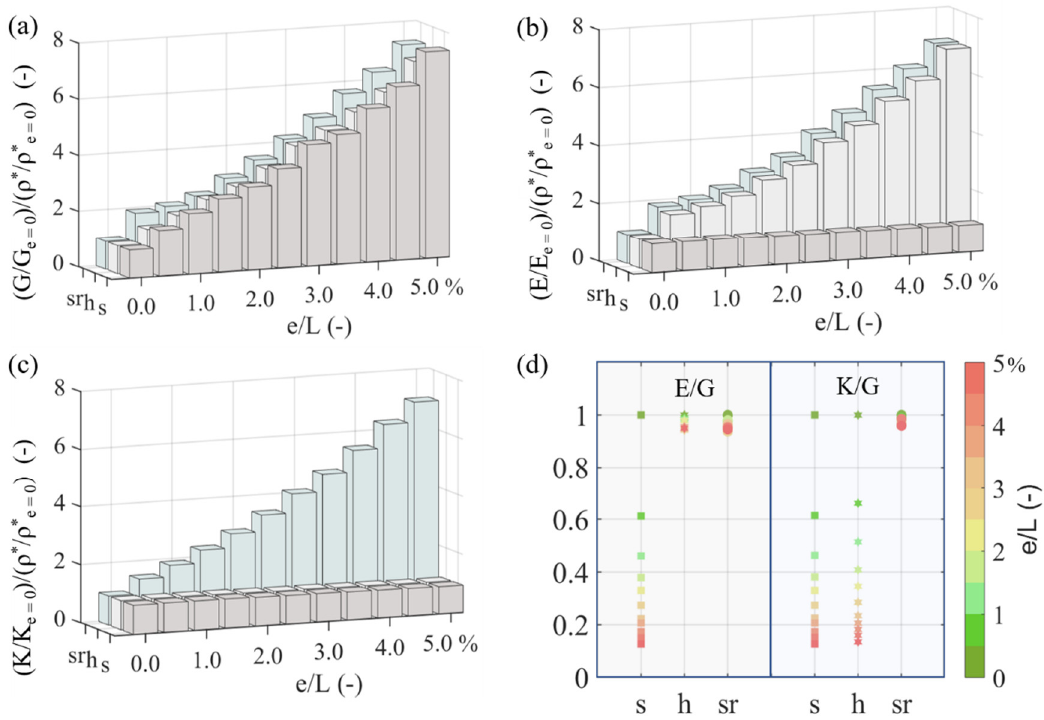
Figure 7. Specific shear ( a ), normal ( b ) and bulk ( c ) modulus per relative density evolution of square (s), honeycomb (h) and star re-entrant (sr) lattice patterns for different element-scale ratios e/L. The specific normal-to-shear E/G and bulk-to-shear K/G moduli ratio values are provided in ( d ) over the same range of e/L values. The analysis is performed for a L / t o ratio of 20 and a t o and t i of 1 and 0.8 mm, respectively.